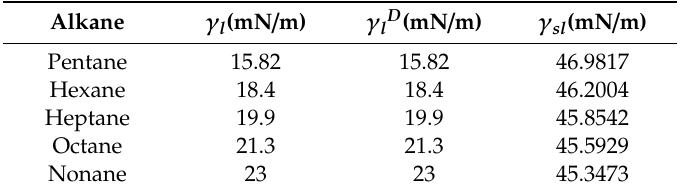
Table 1. Surface energy of alkanes and their respective interfacial energy to microchannel cantilever walls made of silicon nitride (estimated) [63]. Note, alkanes can be considered as purely nonpolar (i.e., γ l ≈ γ lD ). Alkane γ l (mN / m) γ lD (mN / m) γ sl (mN / m)